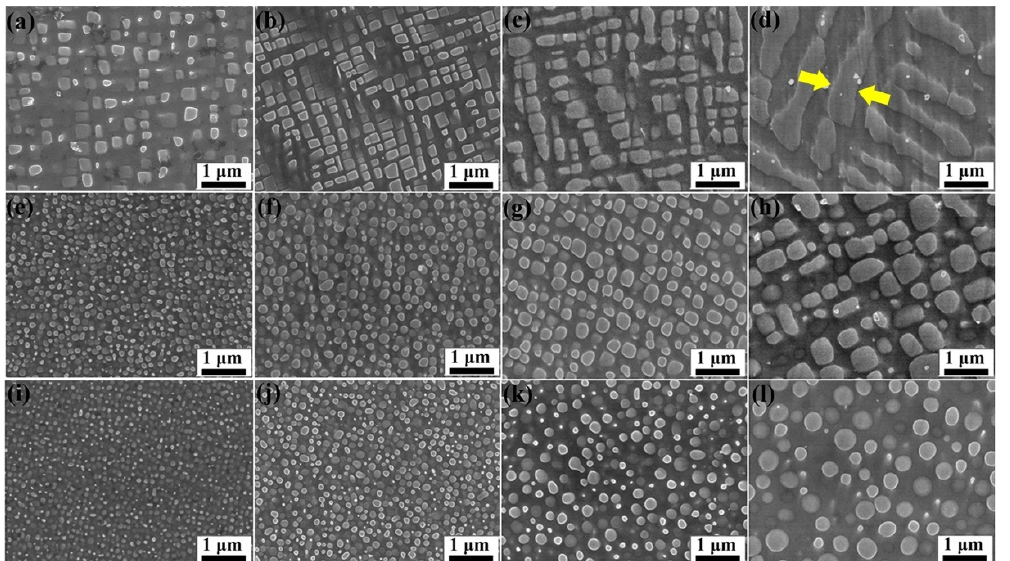
Figure 1. SEM images of NiAl1Ru ( a – d ), NiAl3Ru ( e – h ), and NiAl6Ru ( i – l ) alloys after aging at 900 ° C for 1 h ( a , e , i ), 4 h ( b , f , j ), 24 h ( c , g , k ), and 129 h ( d , h , l ). The mean size of γ (cid:48) precipitates was analyzed using ImageJ software, and the results are shown in Table 2. Here, in order to obtain the accurate γ (cid:48) precipitate size, only the width of the rafted γ (cid:48) precipitate was measured, as marked between the two yellow arrows in Figure 1d. From the data, it can be found that the γ (cid:48) size increased with the prolonging of aging time but decreased with the increase in Ru content. Based on the fact that the growth of γ (cid:48) precipitates is controlled by elemental diffusion [23], the growth of γ (cid:48) precipitates can be described with Lifshitz–Slyosov–Wagner (LSW) theory according to Equation (1) [24]. − − r 0 and r are the initial and instantaneous particle radius, respectively, and k and t where are the growth rate and time,